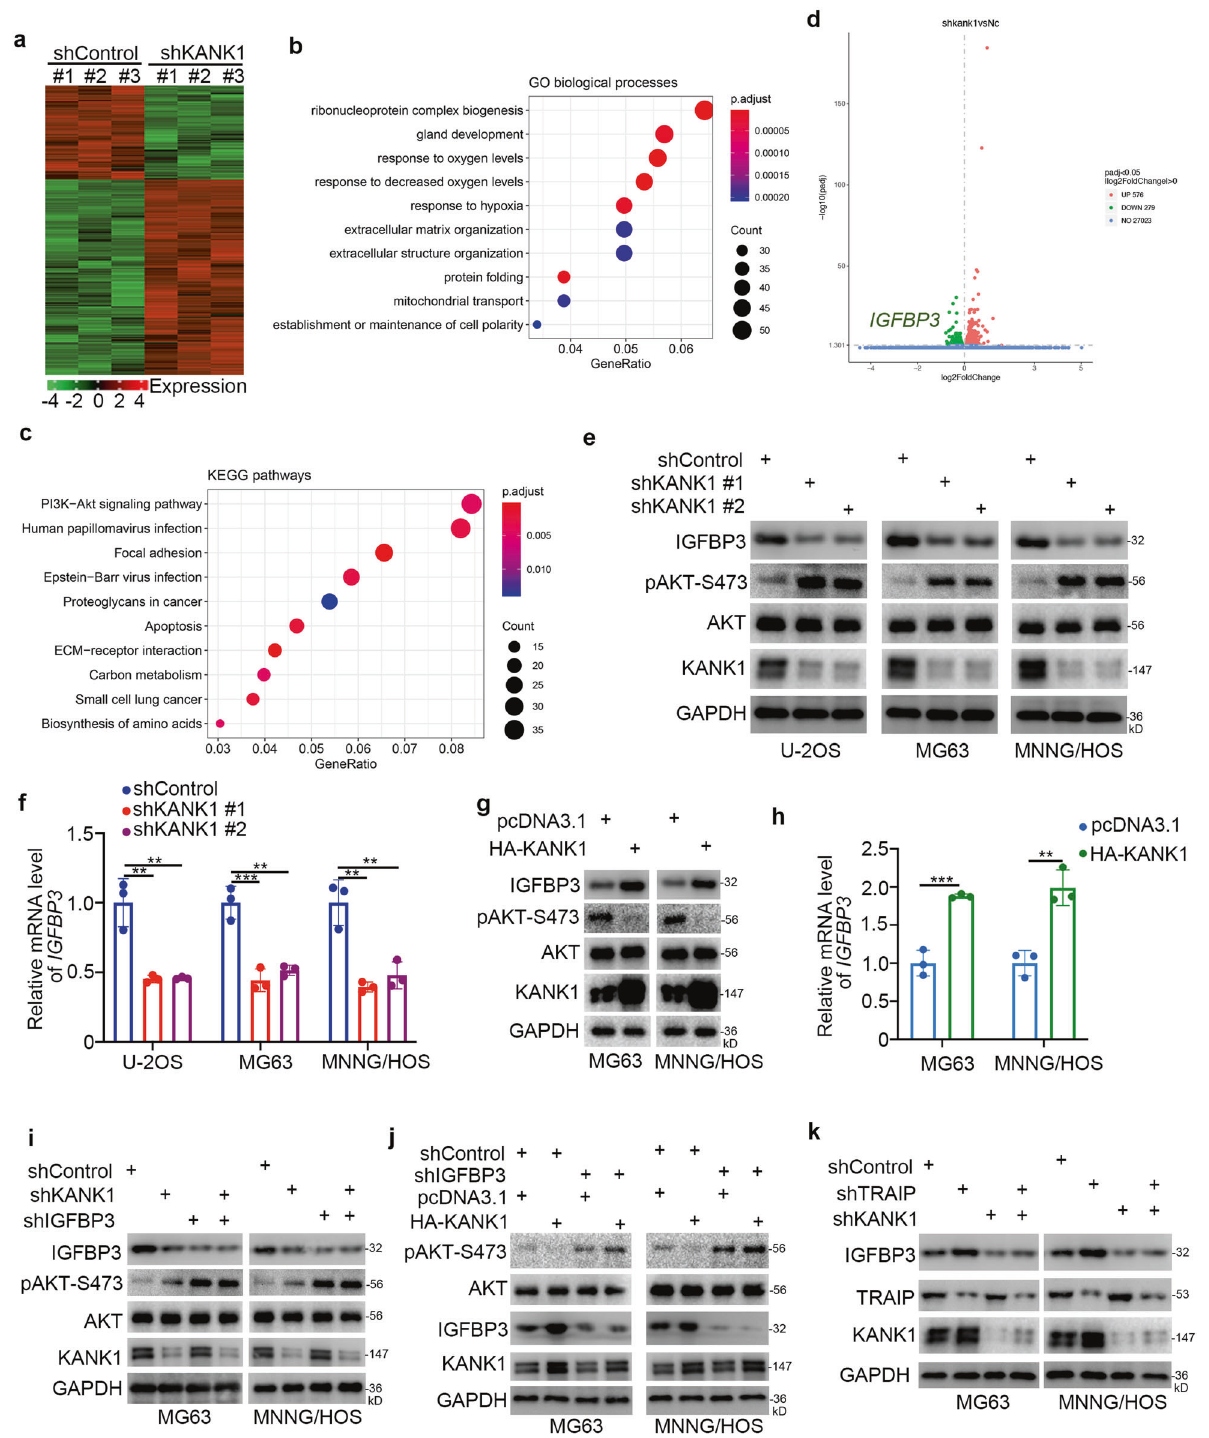
Fig. 7 KANK1 inhibits AKT signaling by upregulating IGFBP3 in osteosarcoma cells. a – d MNNG/HOS cells were infected with the indicated shRNAs for 72 h. Cells were used for RNA-seq analysis a , d . GO ( b ) and KEGG pathway enrichment analyses ( c ) were performed. e , f U-2OS, MG63, and MNNG/HOS cells were infected with the indicated shRNAs. After 72 h, cells were harvested for western blot ( e ) and qRT-PCR analysis ( f ). Data are presented as mean ± SD ( n = 3). ** P < 0.01; *** P < 0.001. g , h MG63 and MNNG/HOS cells were transfected with the indicated plasmids. After 48 h, cells were harvested for western blotting ( g ) and qRT-PCR analysis ( h ). Data are shown as mean ± SD ( n = 3). ** P < 0.01; *** P < 0.001. i Western blot analysis of MG63 and MNNG/HOS cells infected with the indicated shRNAs for 72 h. j Western blot analysis of MG63 and MNNG/HOS cells transfected with the indicated constructs for 72 h. k Western blot analysis of MG63 and MNNG/HOS cells infected with the indicated shRNAs for 72